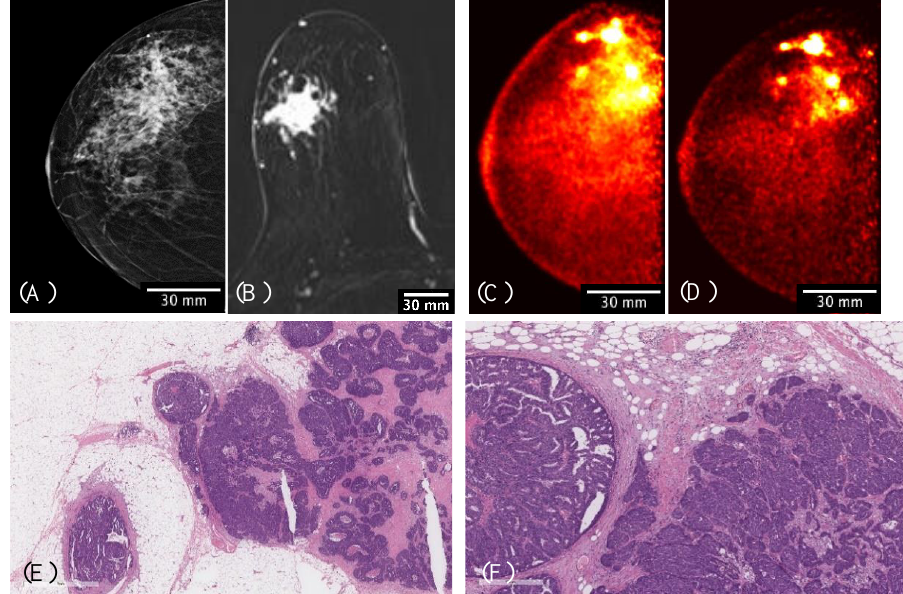
Figure 11. A 61-year-old female with right-breast multifocal invasive and in situ ductal carcinoma. Images of the same breasts in ( A ) FFDM in the CC plane showing extensive distortion, ( B ) a selected slice of MRI in the axial plane showing one irregular shape-enhancing mass lesion after 2 min post gadolinium-chelate-based contrast administration, ( C ) 3D Radialis PET in the CC plane where mul- tiple distinct regions of contrast uptake after 1 h of 178 MBq 18 F-FDG injection are evident, ( D ) 3D Radialis PET in the CC plane where the conspicuity of the multiple regions of enhanced 18 F-FDG uptake (indicative of multifocal cancers) remains after 3 h from the prior ( C ) acquisition, ( E ) invasive carcinoma in the center of the field with in situ carcinoma present at the periphery in the pathology of the mastectomy specimen, and ( F ) higher-power view demonstrating intermediate-grade inva- sive carcinoma on the right and papillary ductal carcinoma in situ on the left. Figure 12 shows the results of FFDM and Radialis PET Camera imaging in a 50-year- old female with a palpable breast lump against the chest wall. The mediolateral oblique (MLO) digital mammography image identified a single palpable mass. Radialis PET Cam- era images were acquired with 200 MBq of injected activity, revealing two additional re- gions of enhanced contrast along the patient’s chest wall, which surgical pathology con- firmed as malignancy.